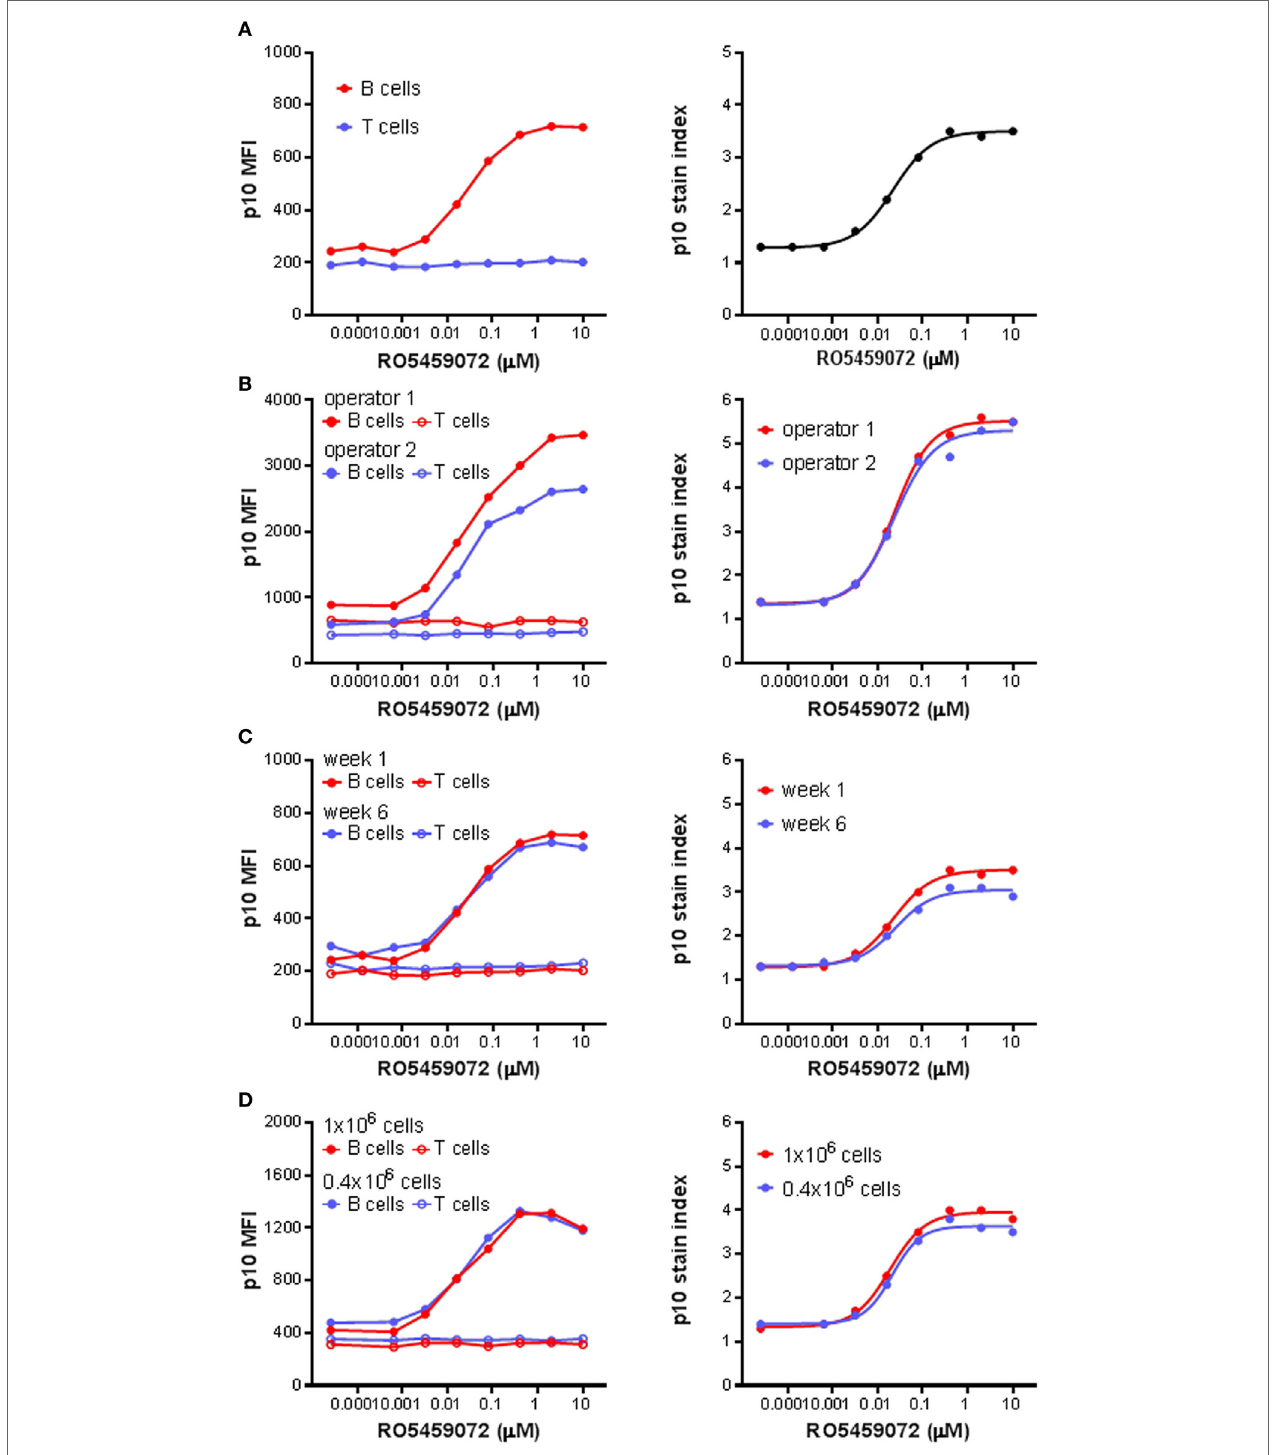
FIgURe 3 | p10 stain index, a robust pharmacodynamic assay readout. (A) p10 stain index values were derived from p10 median fluorescence intensity (MFI) values of B cells of PBMC divided by p10 MFI values of T cells, which acted as an internal negative control. (B) p10 MFI values and derived p10 stain index values from identical samples of PBMC incubated with a serial titration of RO5459072 processed by two different operators. (C) Longitudinal comparison of p10 MFI values and derived p10 stain index values from samples of PBMC obtained from a single healthy volunteer 5 weeks apart and incubated with a serial titration of RO5459072. (d) Impact of variation in cell number incubated with a serial titration of RO5459072 on p10 MFI values and derived p10 stain index. Curve fits were determined by non-linear regression using a variable slope model with GraphPad Prism